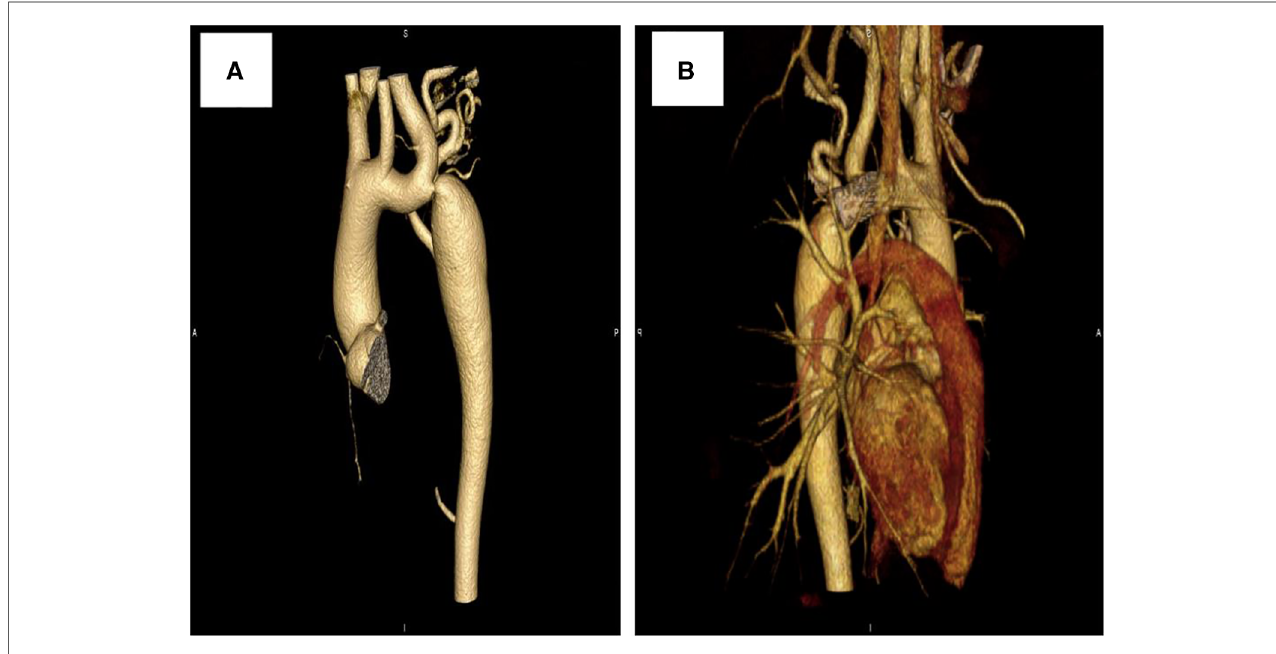
FIGURE 2 Computed tomography scan showing: ( A ) prior to stenting, ( B ) 3 years after